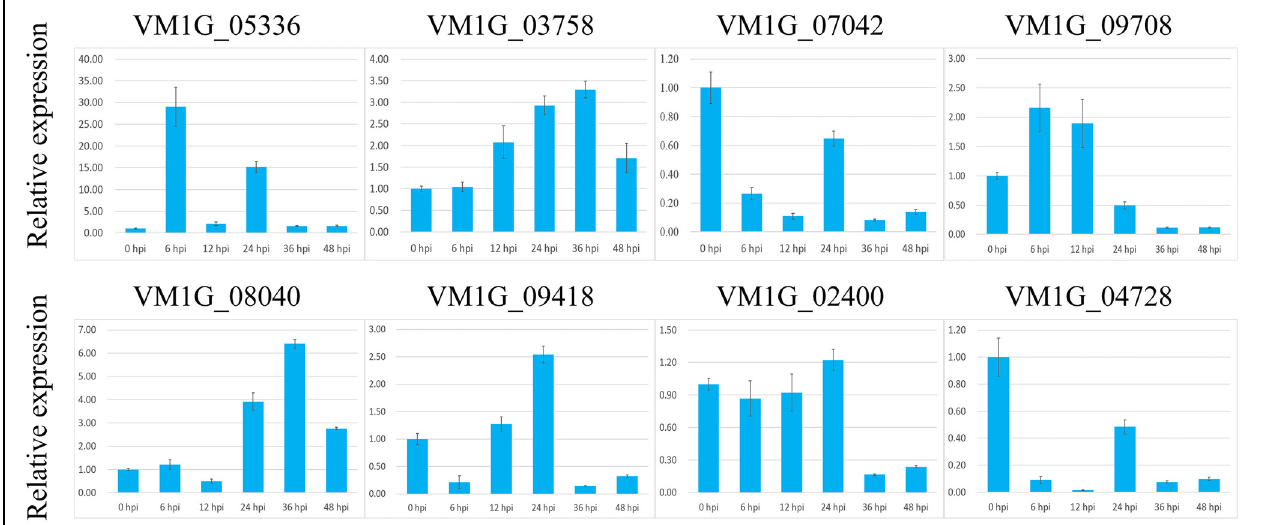
FIGURE 3 | Relative expression level of VmEps at 0, 6, 12, 24, 36, and 48 hours post inoculation (hpi) using reference gene G6PDH for normalization. Results are presented as a mean fold change in relative expression compared to the 0 hpi sampling stage. All experiments were repeated three times. Error bars indicate SEM.